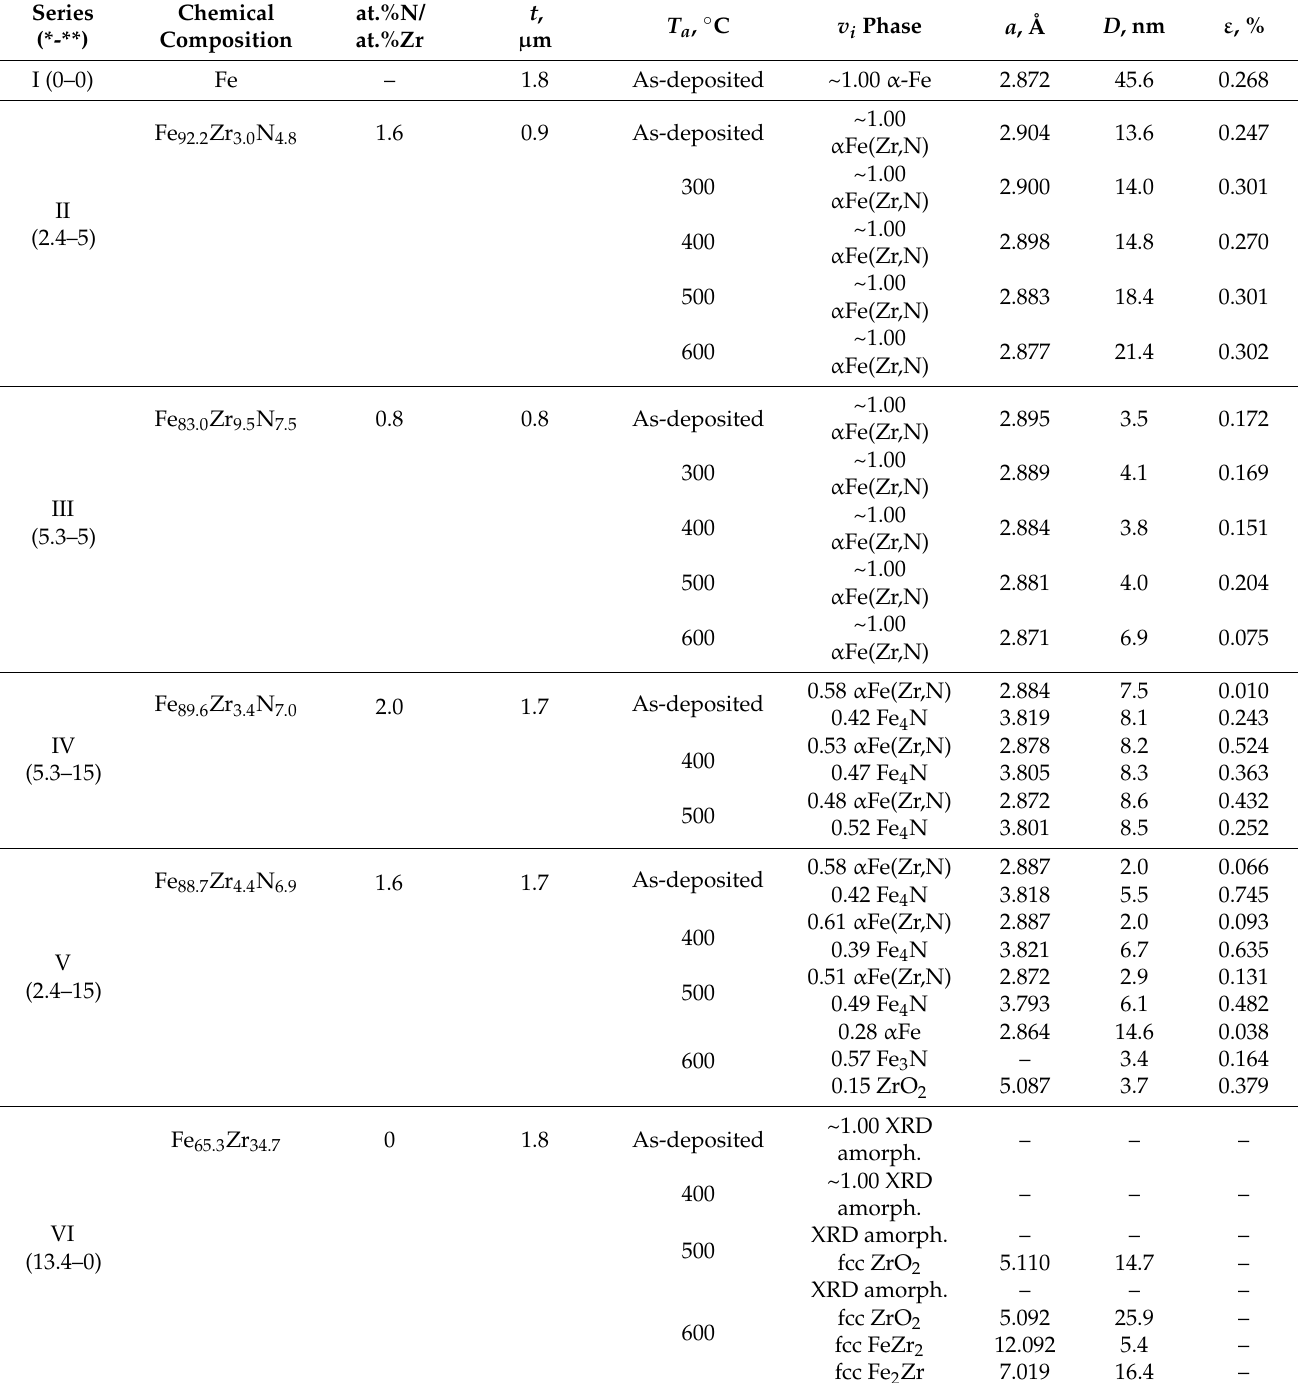
Table 1. The results of the chemical and phase analysis of the